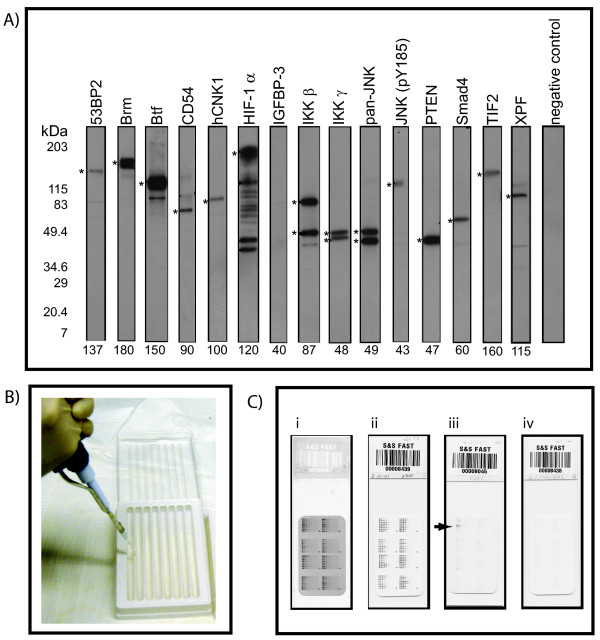
Antibody screening and NCI-60 'reverse-phase' protein lysate microarrays. A) Sixteen 4-mm-wide nitrocellulose strips from a nitrocellulose membrane blot, each used to test a different antibody. Each blot was classified by the criteria described in the text. Asterisks indicate predominant band(s). Eight blots (53BP2, Brm, Btf, hCNK1, PTEN, Smad4, TIF2, and XPF) were classified as single band and the expected molecular weight. Four blots (HIF-1 α, IKK β, IKK γ, and pan-JNK) were classified as multiple bands. Two blots (CD54, and JNK pY185) were classified as wrong molecular weight. One blot (IGFBP-3) was classified as no band. All band results from this Western blotting were entered into AbMiner. It should be noted that the results in this figure may not correspond to the band results in AbMiner because the latter are sometimes updated after additional testing. B) Miniature incubation chambers for 4-mm strips used for incubations with primary and then secondary antibodies. C) Reverse-phase lysate arrays. Each row consists of 10 two-fold dilutions of an NCI-60 cell line or a control pool consisting of all 60 cell lines. Concentrated pool was spotted at the bottom-right corner of each field to serve as a registration mark for image processing. i) lysate array stained for total protein with SYPRO Ruby. ii) lysate array incubated with an antibody for p300, a protein ubiquitously expressed in the NCI-60. iii) CDK2 expression across 60 cell lines. Only one cell line shows visible expression (arrow). Nonetheless, expression of CDK2 was still detected as a single band by Western blot iv) Negative control. The primary antibody was replaced by anti-Aspergillus niger glucose oxidase IgG1, which does not recognize any human antigen.